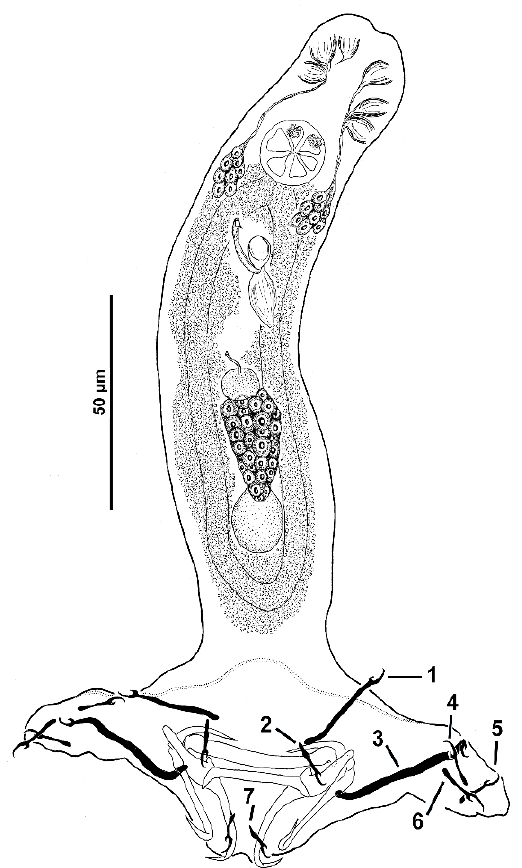
Figure 2. Whole mount of Neohaliotrema variabilis n. sp. (composite, ventral view) from the beaugregory Stegastes partitus showing position of hook pairs 1–7.